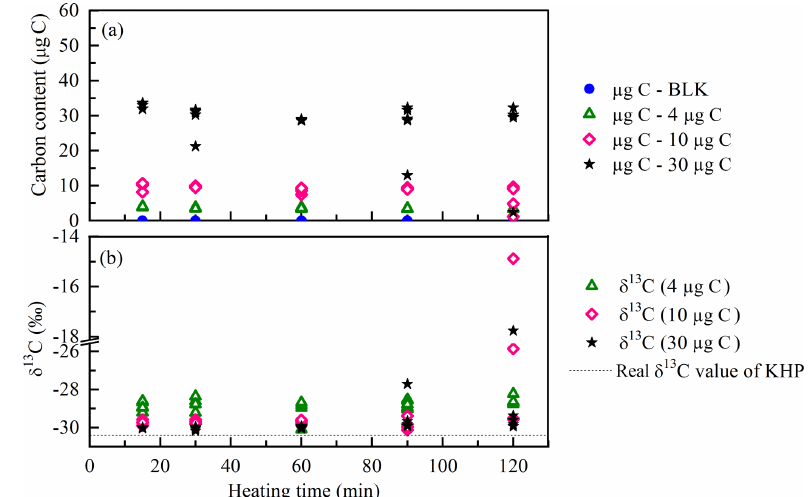
Figure 2. Carbon content (a) and isotopic ratios (b) of KHP after different heating